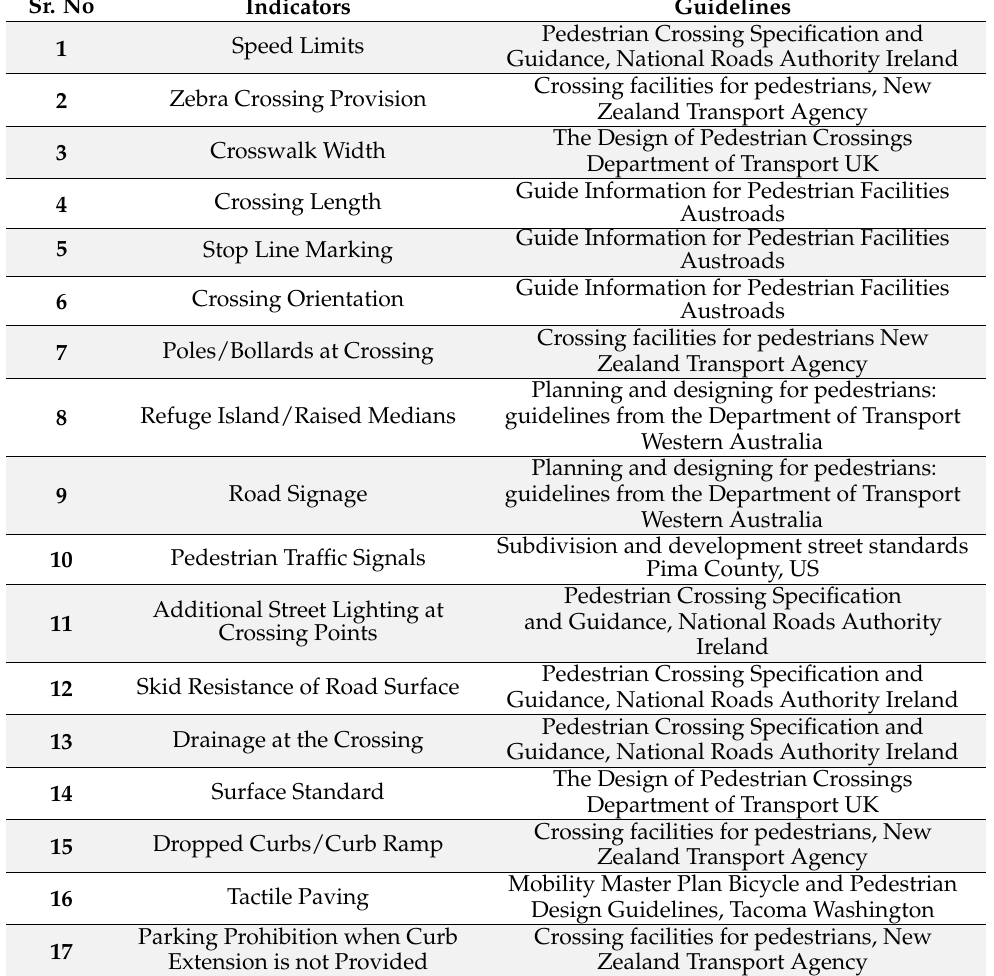
Table 2. Selected PCLOS